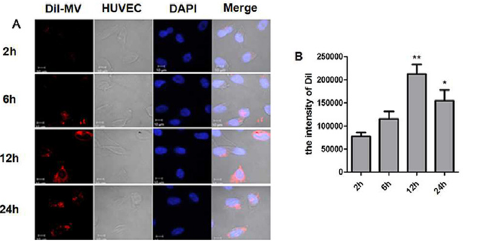
Fig 3. Incorporation of MSC-MVs into HUVECs observed with confocal laser microscopy. (A) DiI- labeled MSC-MVs were added into the HUVEC culture. The cells were fixed and DAPI-stained, followed by confocal observation. Red: DiI-MVs; Blue: DAPI; Ordinary light: HUVEC; and Merge: the merged images of the three above. Bar: 10 μ m. (B) The mean fluorescence intensity of DiI in per field. The results are representative of three individual experiments.